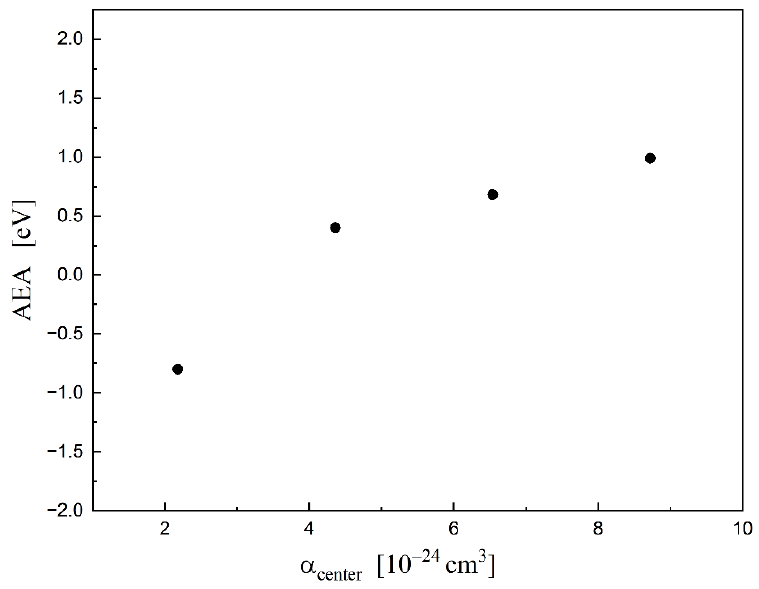
Figure 7. Dependence of the AEA on α center for: SiH 3 Cl, SiH 2 Cl 2 , SiHCl 3 , SiCl 4 .